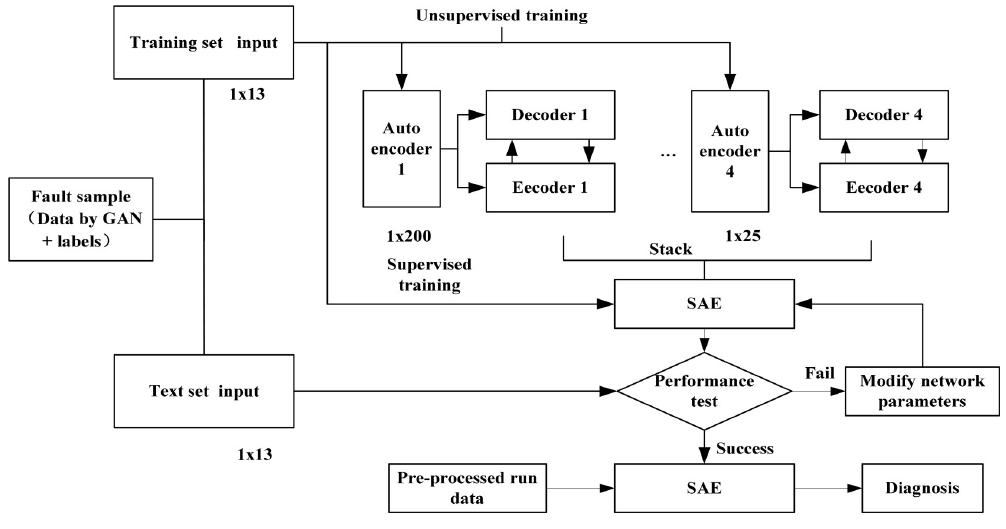
Fig 12. GAN-SAE network structure.